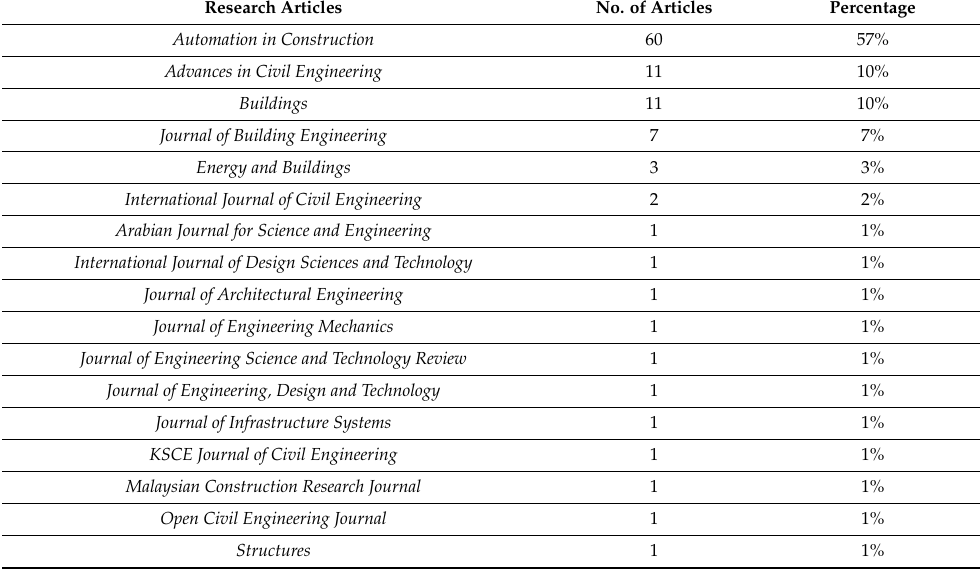
Table 1. Contribution of journals toward sustainable development.